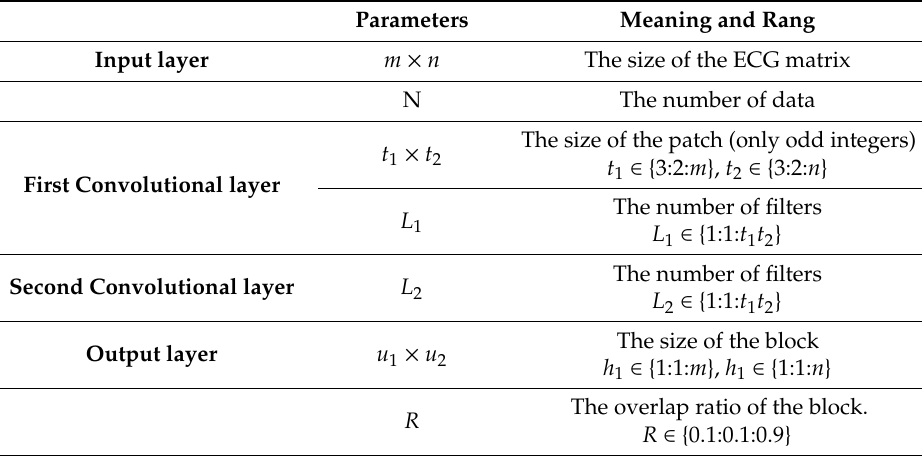
Table 5. The detailed parameters of DL-CCANet and